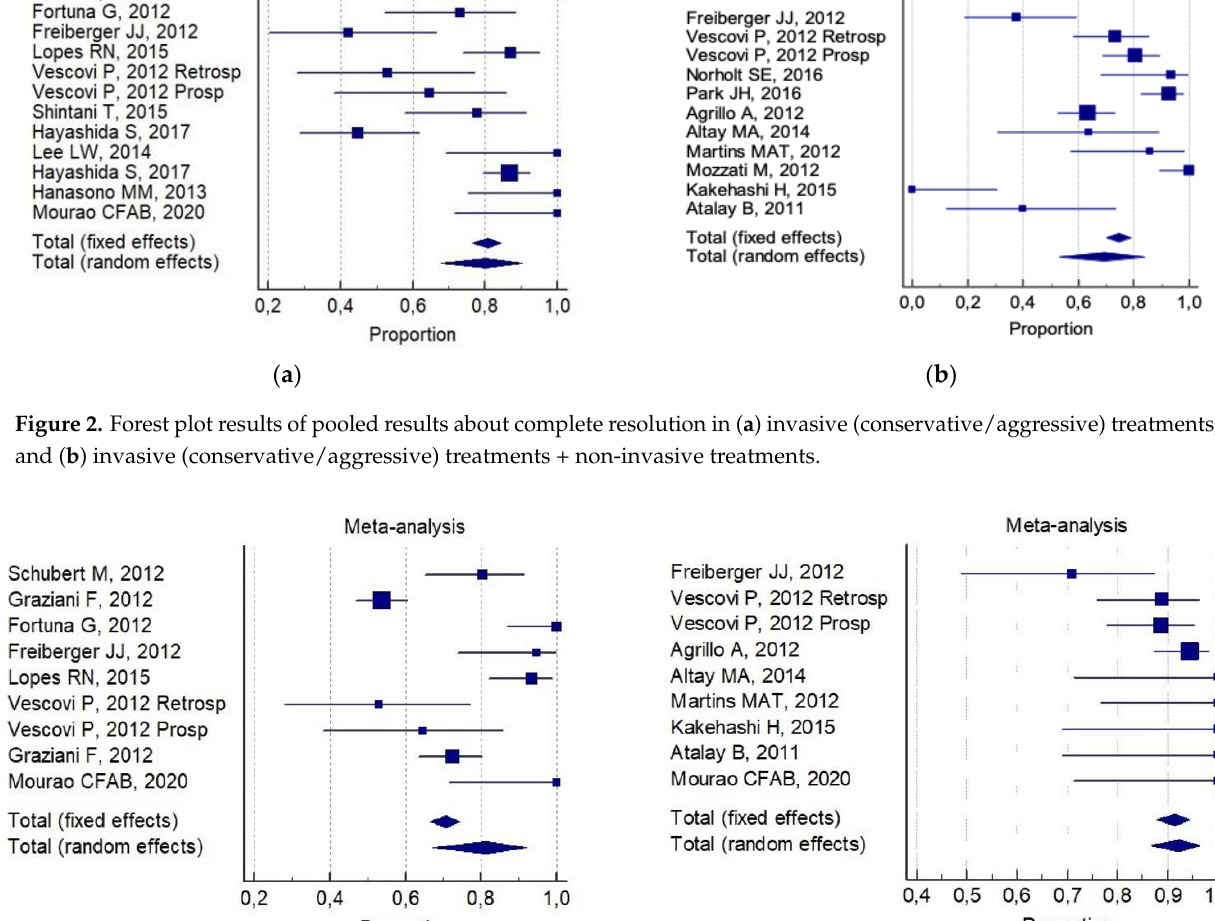
Figure 3. Forest plot results of pooled results about complete resolution in ( a ) invasive (conservative/aggressive) treatments, and ( b ) invasive (conservative/aggressive) plus non-invasive